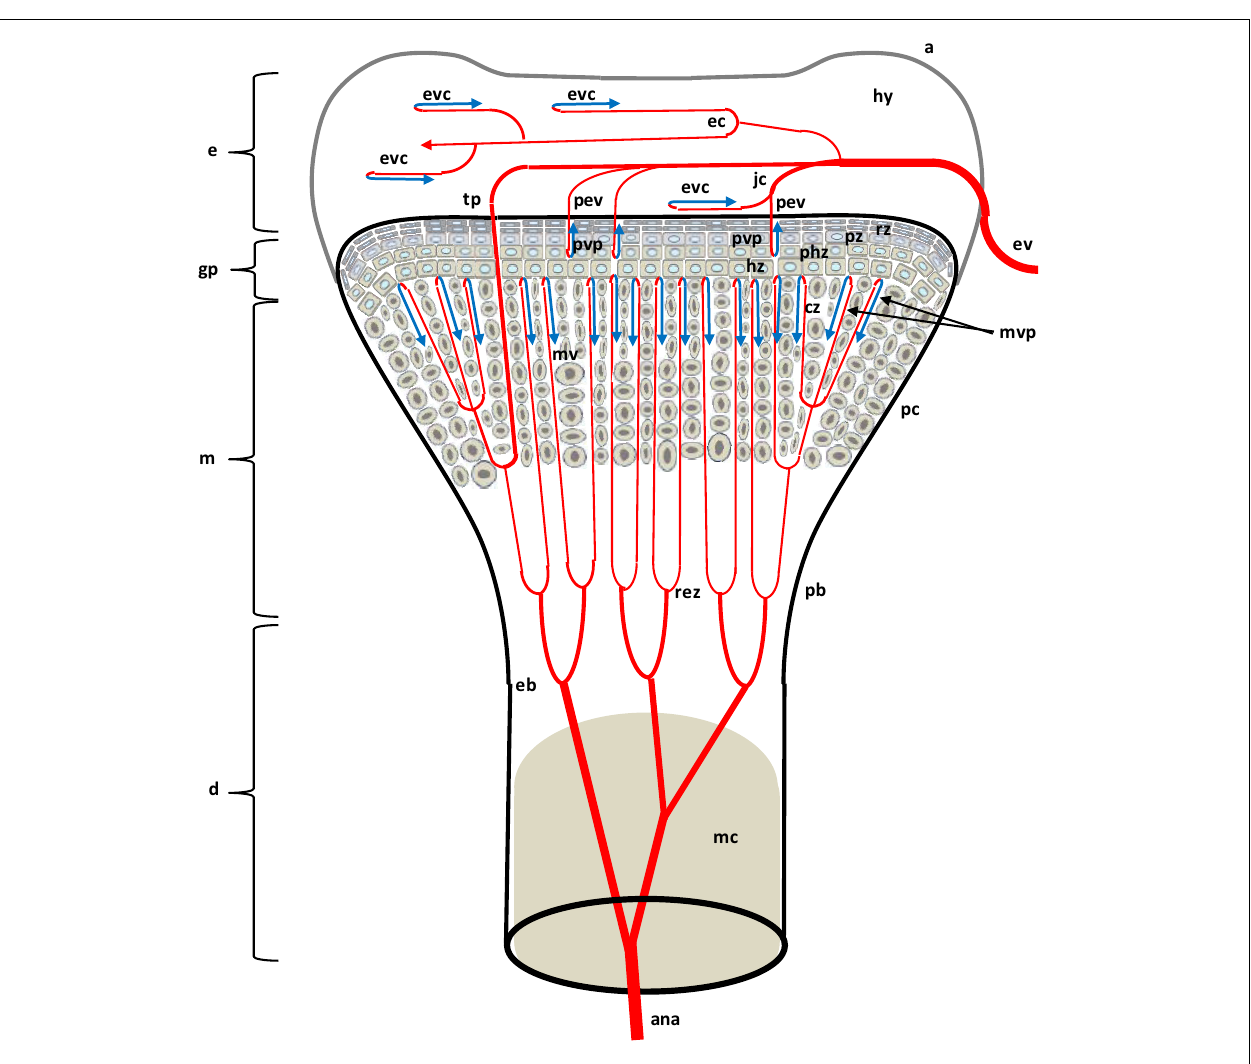
terminate as the metaphyseal vascular capillary plexus (mvp) supplying the calcifying zone (cz, also known as the degenerating hypertrophic zone) of the metaphysis.The hypertrophic zone (hz) normally is not penetrated by the pvp or mvp, but may rarely be penetrated by transphyseal vessels (tp). Additional features include: a articular zone of epiphyseal cartilage; eb, endosteal bone; mc, medullary cavity; pb, periosteal bone; and